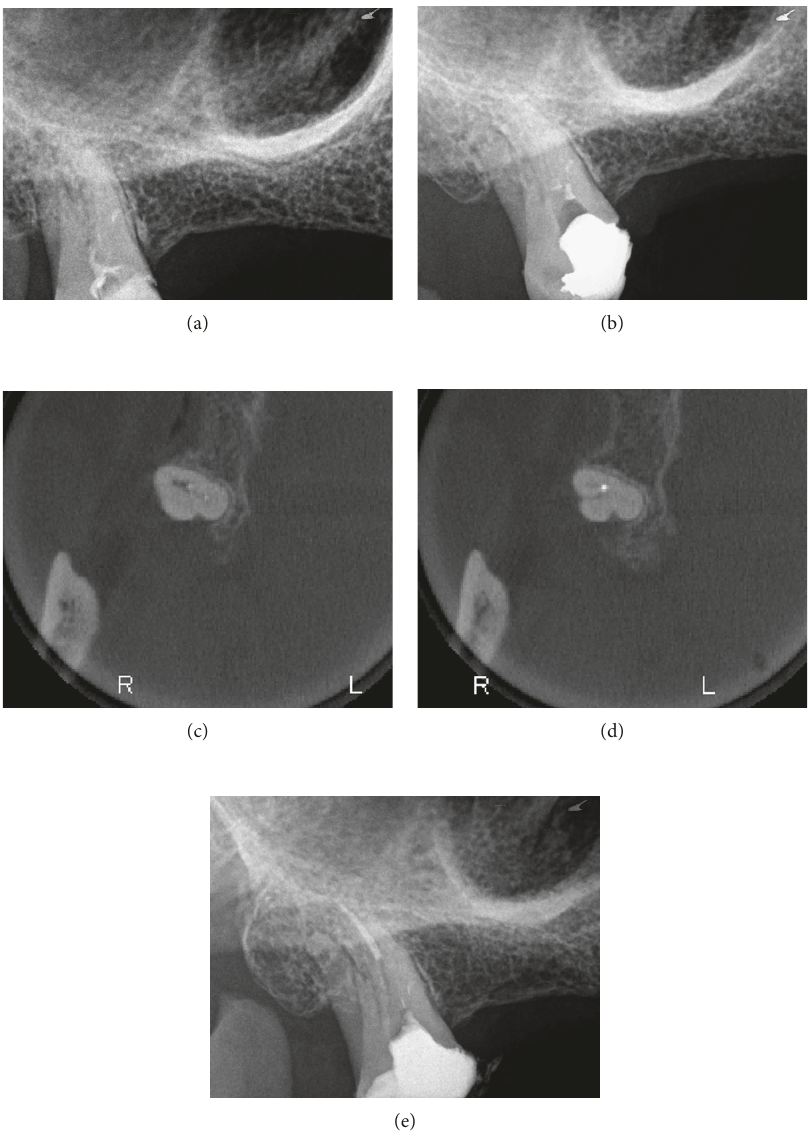
Figure 3: Treatment sequence of tooth 18. (a) Preoperative radiograph. (b) Intraoperative radiograph with gutta-percha points. (c) Axial view of intraoperative CBCTwith both gutta-percha points. (d) Axial view of intraoperative CBCTwith mesiobuccal gutta-percha point. (e) Postoperative